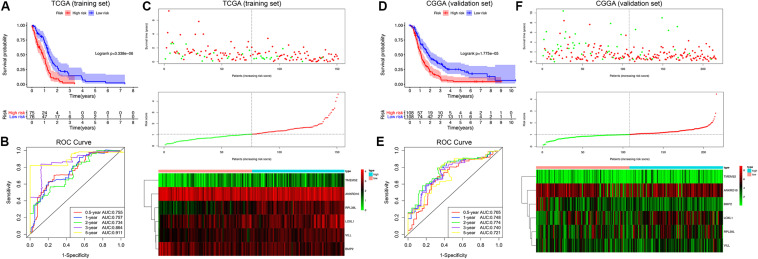
Survival analysis, prognostic performance and risk score analysis of the MDG-based risk score model in GBM. K-M survival analysis was performed to estimate the prognosis of patients with high risk scores and low risk scores in the TCGA training cohort (A) and CGGA validation cohort (D). The high-risk groups had significantly poorer OS than the low-risk groups. The prognostic performances of the MDG signature demonstrated by the time-dependent ROC curve for predicting the 0. 5-, 1-, 2-, 3-, and 5-year OS rates in the TCGA training cohort (B) and CGGA validation cohort (E). Risk score analysis of the MDG signature in the TCGA training cohort (C) and CGGA validation cohort (F). Upper panel: Patient survival status and time distributed by risk score. Middle panel: Risk score curves of the MDG signature. Bottom panel: Heat maps of the expressions of the 6 MDGs in the GBM samples. The colors from green to red indicate the expression level from low to high.